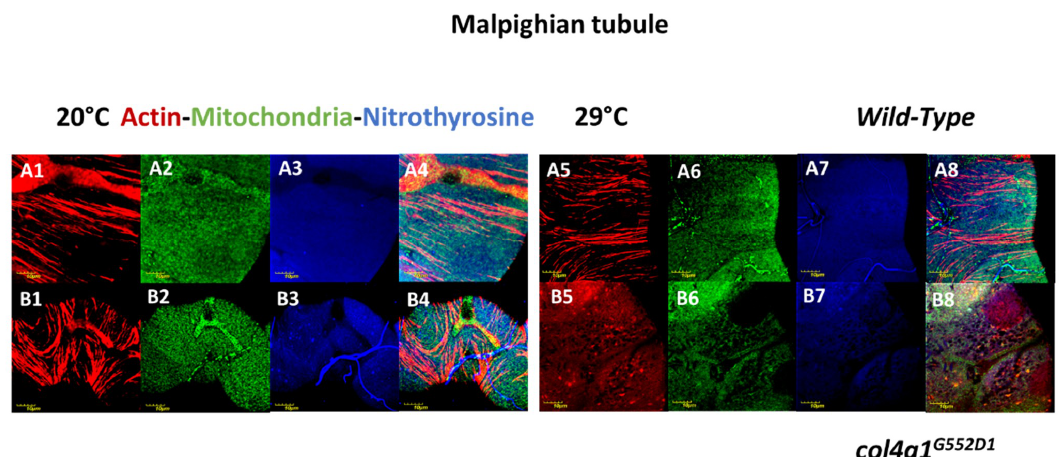
Figure 3. Compromised Malpighian tubules in mutants. Fusion and uneven distribution of mitochondria as a consequence of mutation-induced stress. Even distribution of mitochondria in wild-type control (A2, A6) and in the mutant under the permissive condition (B2) is independent of the incubation temperature. Large aggregates of mitochondria in the mutant appear at 29 °C (B6, upper left). Bars, lower left: 10 micrometers. Experiments were carried out as described [24,25,26,28,29].